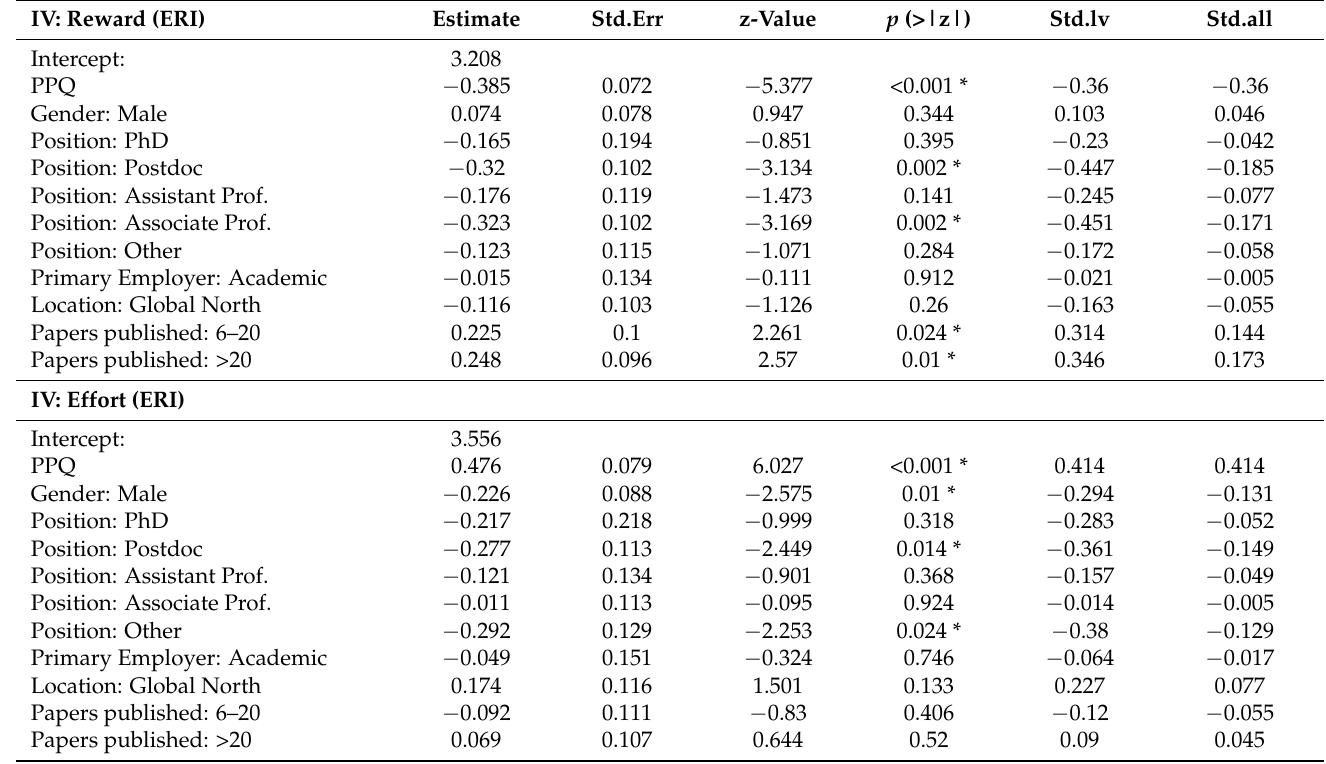
Table 4. Extracted output for the two forms of the independent variable “Distributive Justice” from the regression analysis of our SEM model. * indicates statistical significance ( p < 0.05).